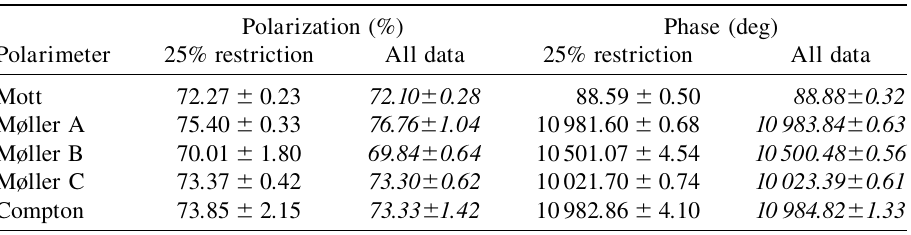
TABLE V. Polarization and phase results for polarimeter data restricted to be within 25% of the maximum polarization measured; italicized text show results using all data (see Table IV) for comparison. The uncertainties are the total standard error in the fit parameters using the least squares fitting routine. Results presented in this table use (cid:12) (cid:5) 5 : 630 (cid:3) = kV